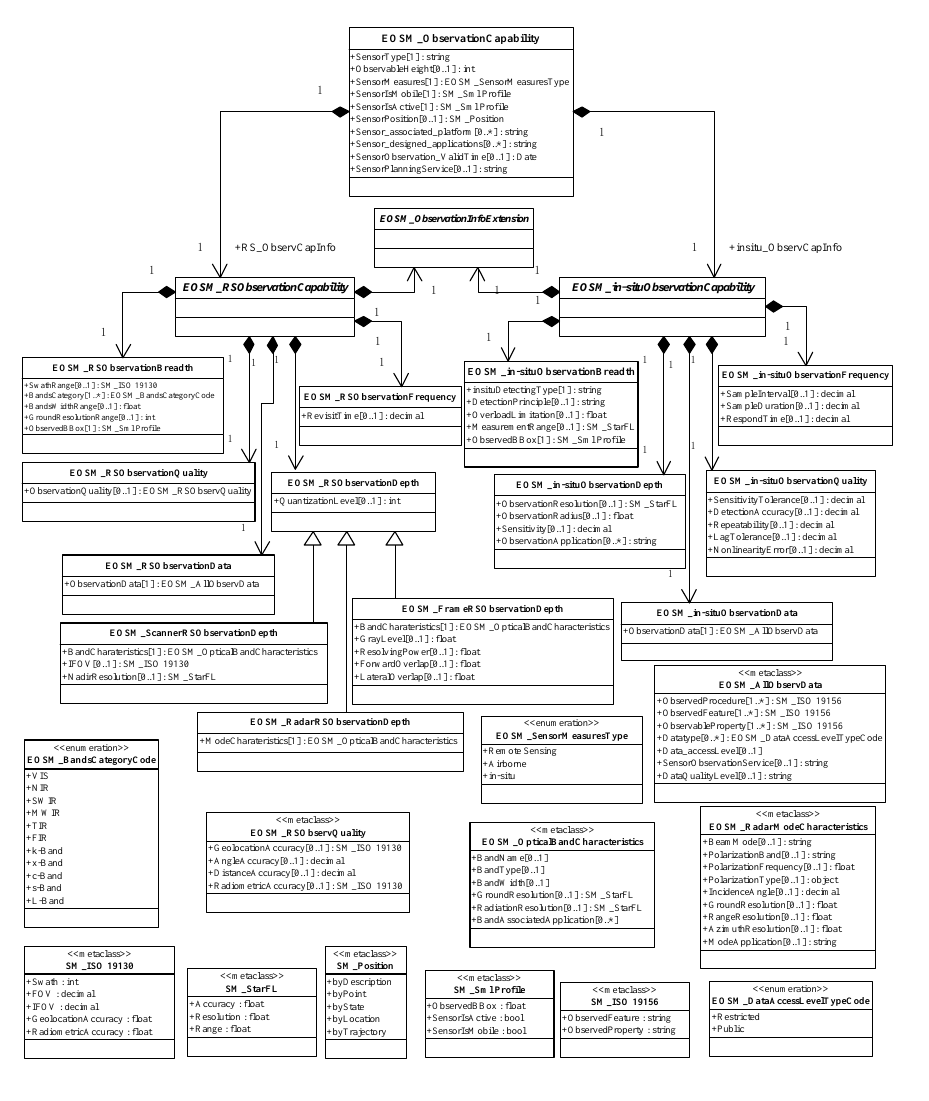
Figure 4. UML diagram of EO sensor observation capability metadata model